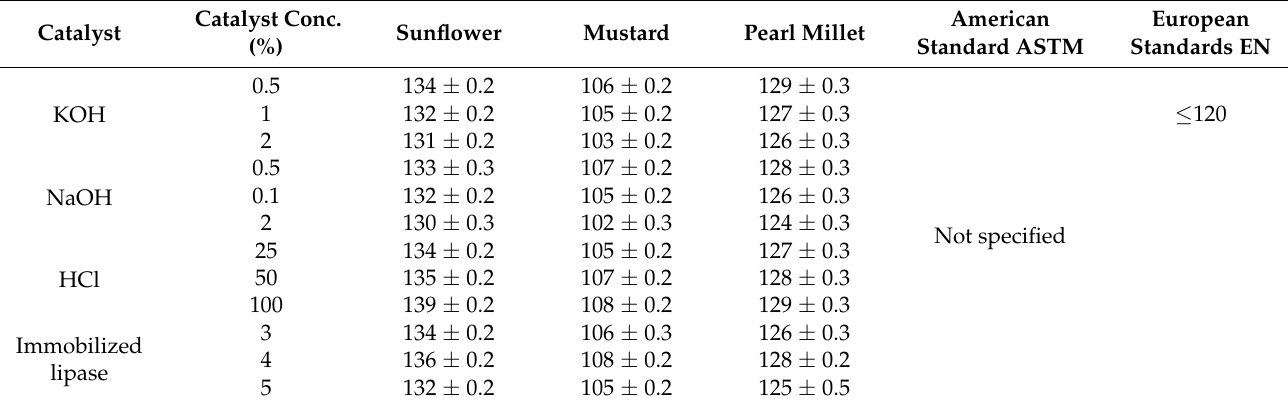
Table 3. Iodine value (g I 2 /100 g) of biodiesel from sunflower, mustard, and pearl millet seed oils. Catalyst